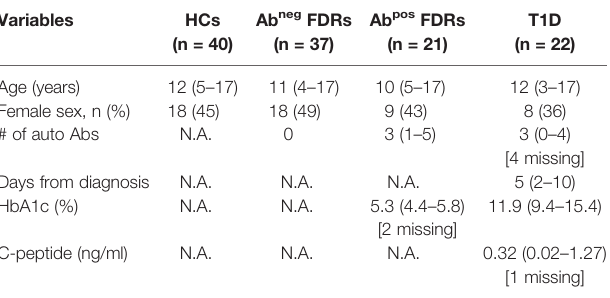
TABLE 1 | Characteristics of subjects enrolled in the study.